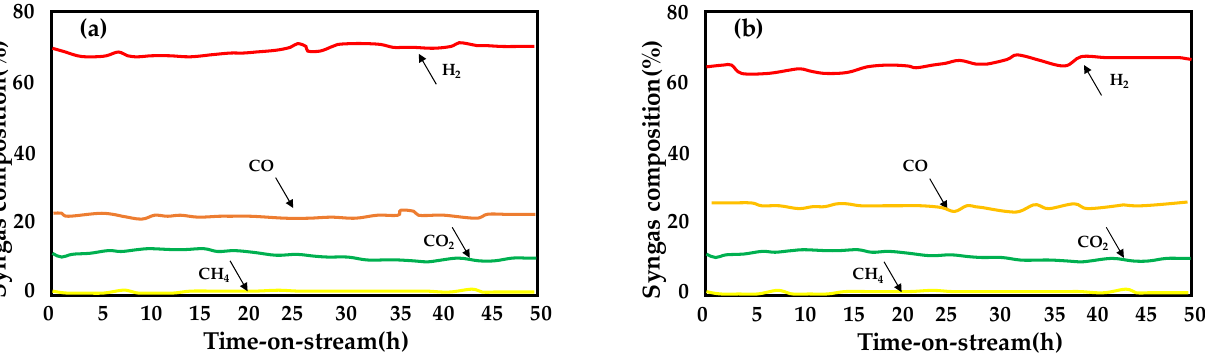
Figure 4. Syngas composition obtained over a monolith washcoated with Rh–Pt/CeO 2 –SiO 2 using ( a ) synthetic bioethanol and ( b ) actual bioethanol obtained from glucose standards. Adapted from [21]; T = 700 °C; P = 1 atm; H 2 O/C 2 H 5 OH = 3; SV = 0.17 g ethanol ·g cat − 1 min − 1 .